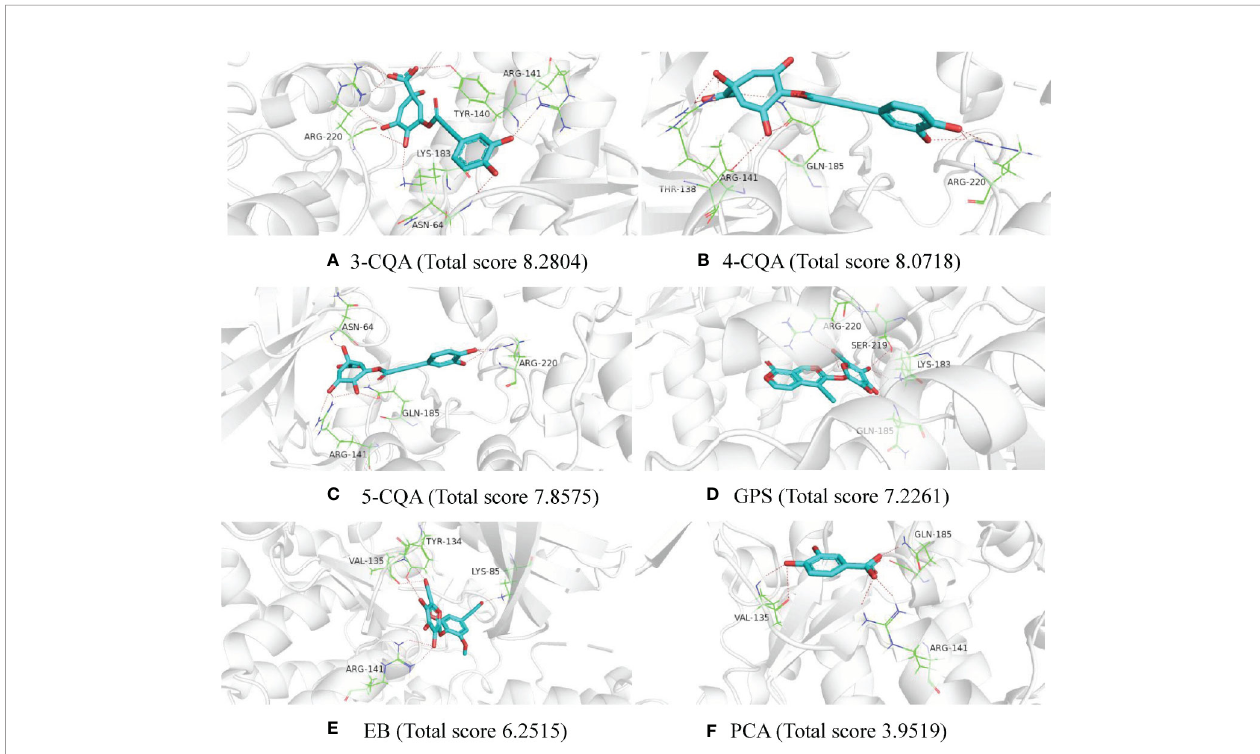
FIGURE 4 | Molecular docking charts of 6 compounds (including 3-CQA (A) , 4-CQA (B) , 5-CQA (C) , GPS (D) , EB (E) and PCA (F) ) and GSK3B (PDB ID